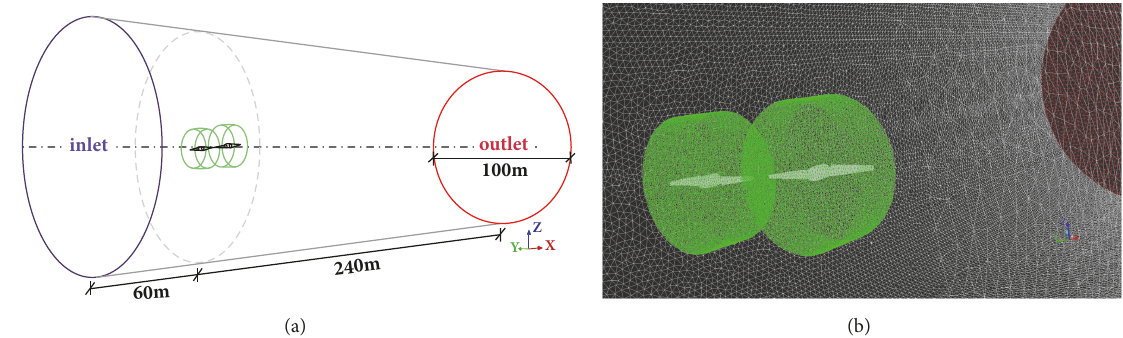
Figure 4: Computational domain and grids: (a) schematic of computational domain and (b) 3-D grids.